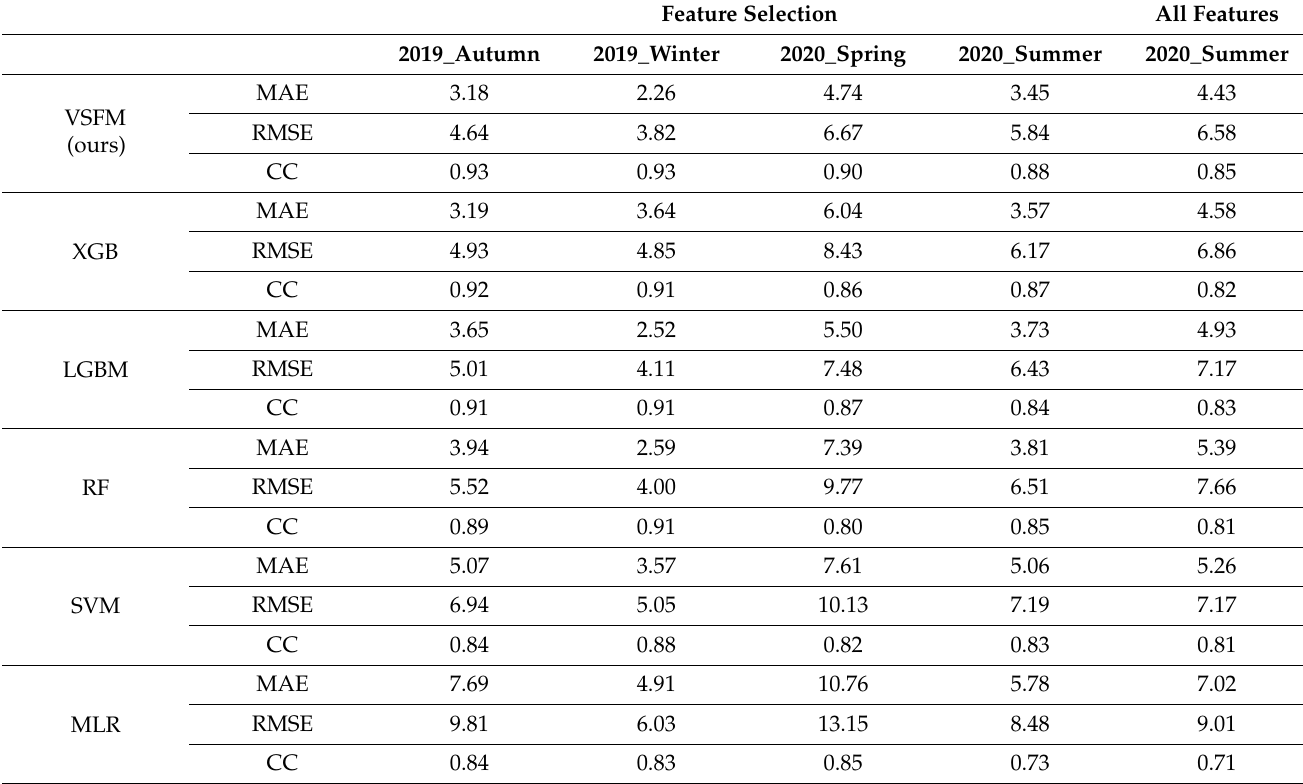
Table 3. Error comparison of models in different seasons, where the MAE and RMSE are in